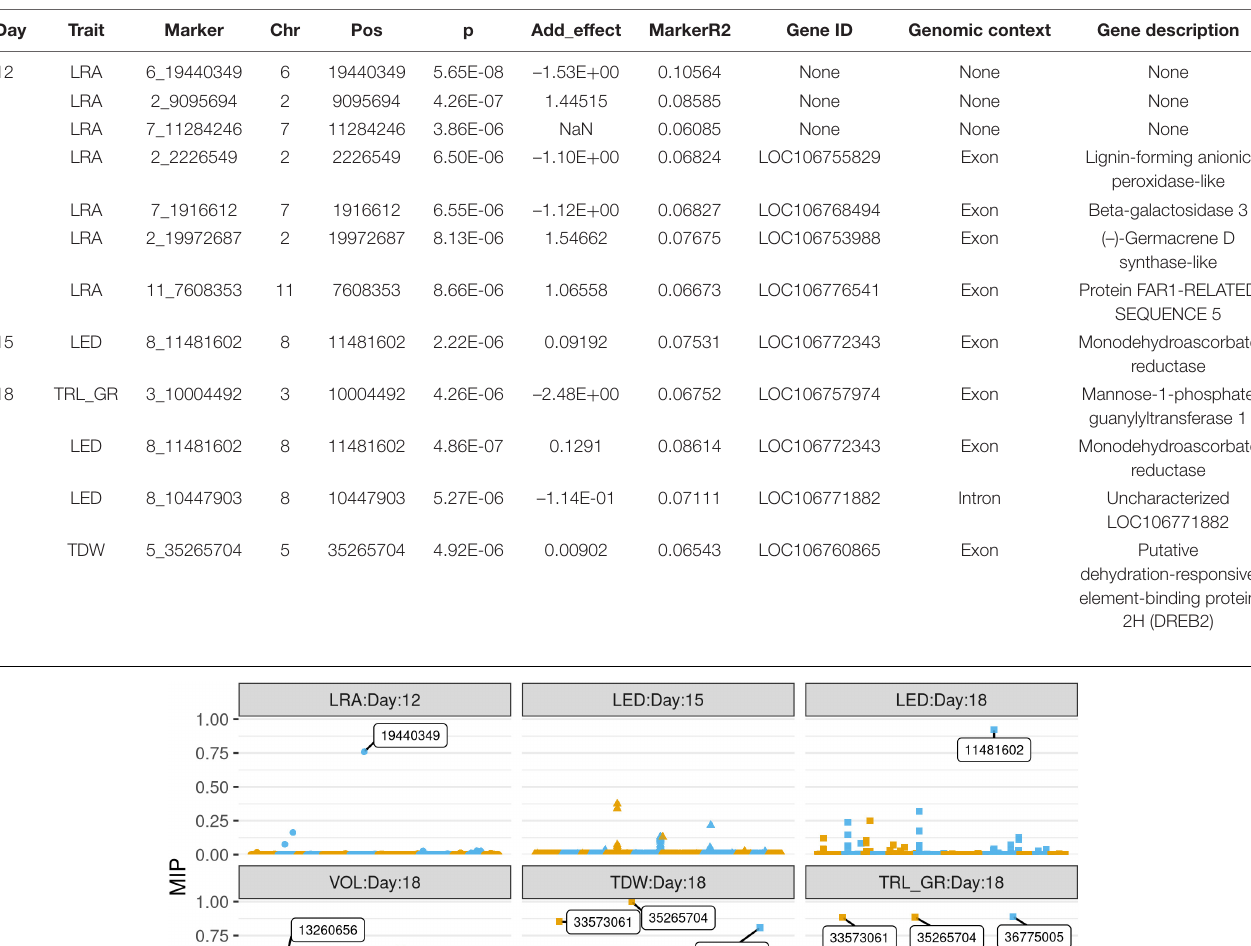
TABLE 4 | Significant single-nucleotide polymorphisms (SNPs) for results of association studies for traits across days 12, 15, and 18 as run in the Trait Analysis by aSSociation, Evolution, and Linkage (TASSEL) software.